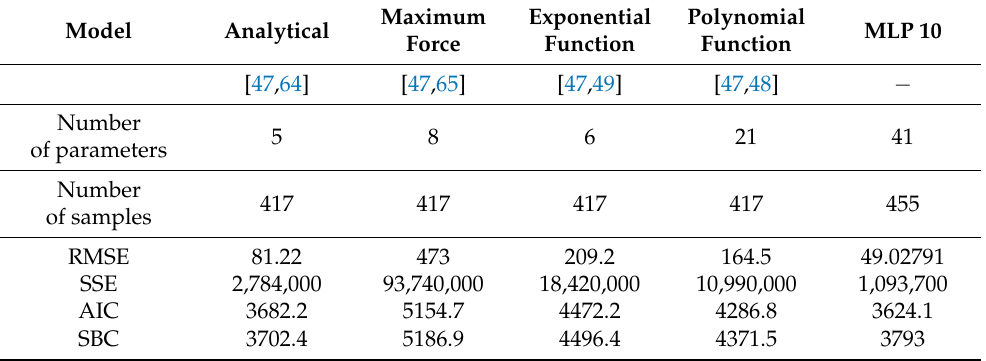
Table 18. Performance comparison of several state-of-art models with the best ML